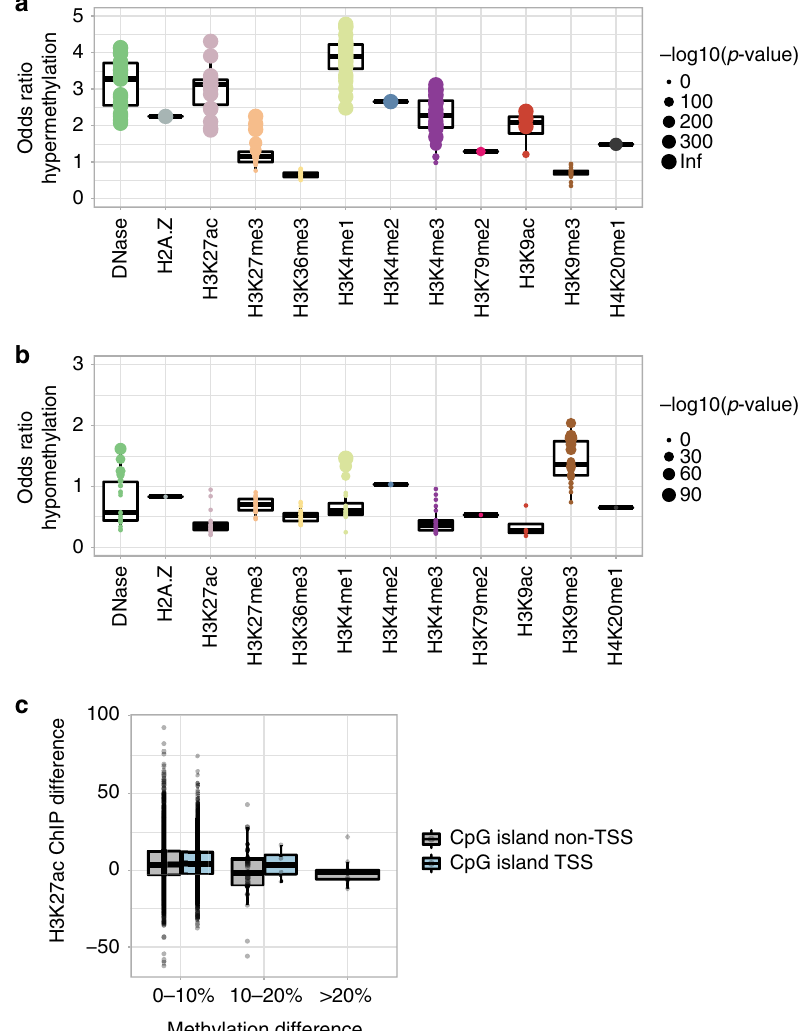
Fig. 3 Hypermethylation caused by TET2 loss is enriched at active enhancer regions. a , b Regions with different chromatin marks in 24 different subtypes of primary human blood cells (each subtype represented by a dot) were available from the Roadmap Epigenomics project. These were compared to the hyper- and hypomethylated sites detected in blood whole-genome bisul fi te sequencing (WGBS) of three cancer-free TET2delA carriers relative to three age-matched non-carriers. a The hypermethylated sites in TET2delA carriers were characterized by frequent presence of normally H3K4me1-marked chromatin in primary blood cells. In addition, hypermethylation was enriched strongly at DNaseI hypersensitive and H3K27ac-marked chromatin, suggesting that methylation was increased in enhancer regions that are normally active. b The hypomethylated sites in TET2delA carriers were enriched at normally H3K9me3-marked regions that typically represent transcriptionally repressed heterochromatin. Odds ratios and p -values from the Fisher ’ s exact test implemented in LOLA R package. c Chromatin immunoprecipitation with an anti-H3K27ac antibody in lymphoblastoid cells from TET2delA carriers (Ly9, Ly11, and Ly14) was compared to that from wild-type individuals (Ly8 and Ly10). The difference in the enrichment of active H3K27ac-marked chromatin at CpG islands is displayed as a function of increasing methylation at CpG islands in whole blood of the TET2delA carriers as measured by WGBS. Negative correlation is stronger at CpG islands outside transcription start sites (TSS). Boxplots show the median, and the fi rst and third